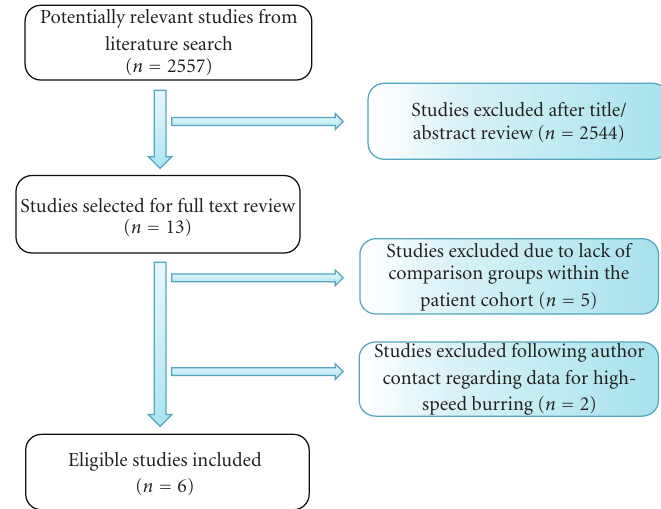
Figure 1: Literature search flow diagram.